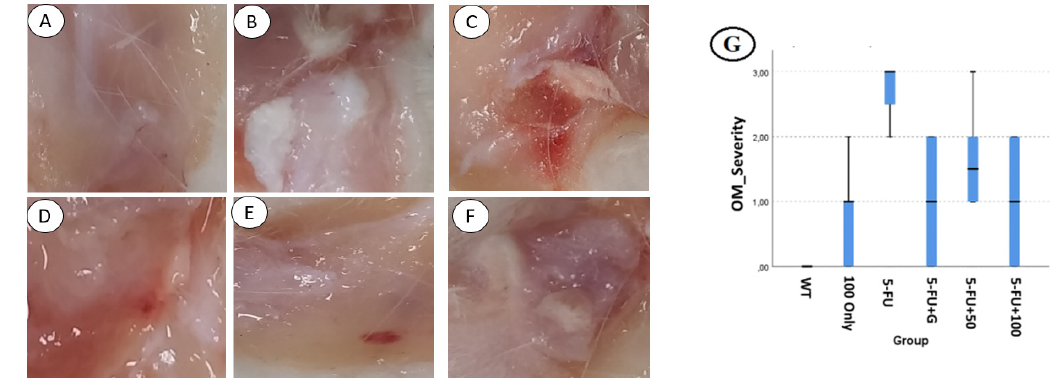
Figure 5. The representative oral buccal mucosa clinical features of rats in each experimental group after sacrifice. Images from WT group ( A ), 100-only group ( B ), 5-FU group ( C ), 5-FU+G group ( D ), 5-FU+50 group ( E ), and 5-FU+100 group ( F ). ( G ): Box and whisker chart of independent-samples Kruskal–Wallis test (nonparametric test) of OM severities in the six experimental groups. All values are expressed as mean ± SD of each group.